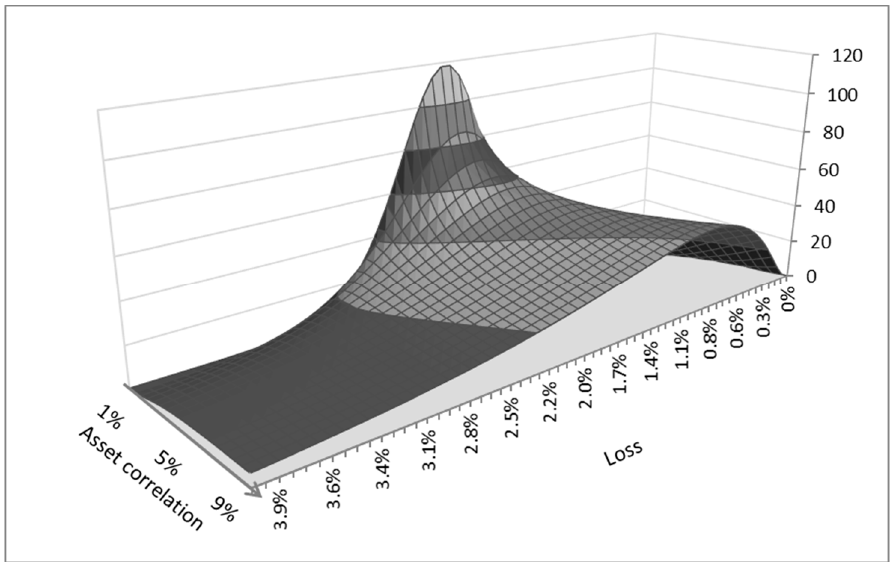
Figure 3. Loss distribution functions depending on asset correlation.